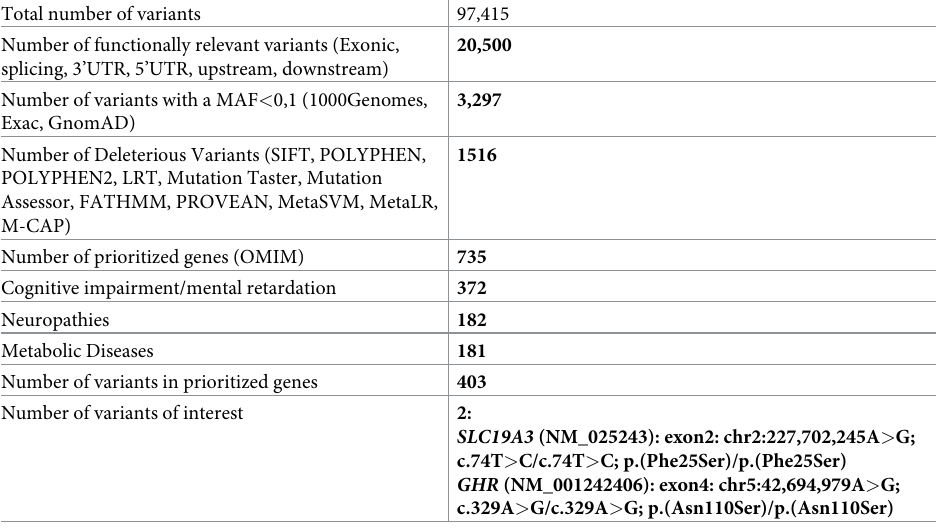
Table 3. Variant prioritization workflow in the exome analysis of TNDF182-6